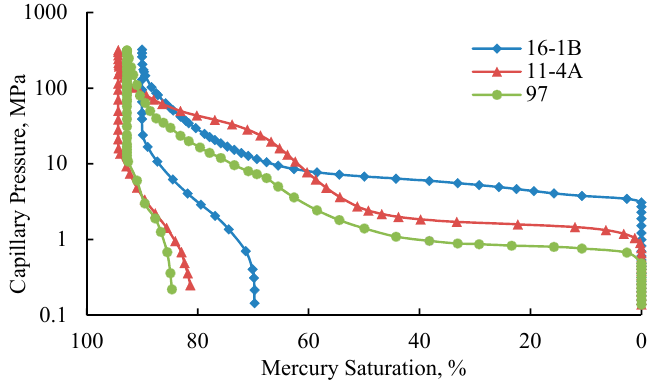
Figure 4. HPMI curves of the three cores.